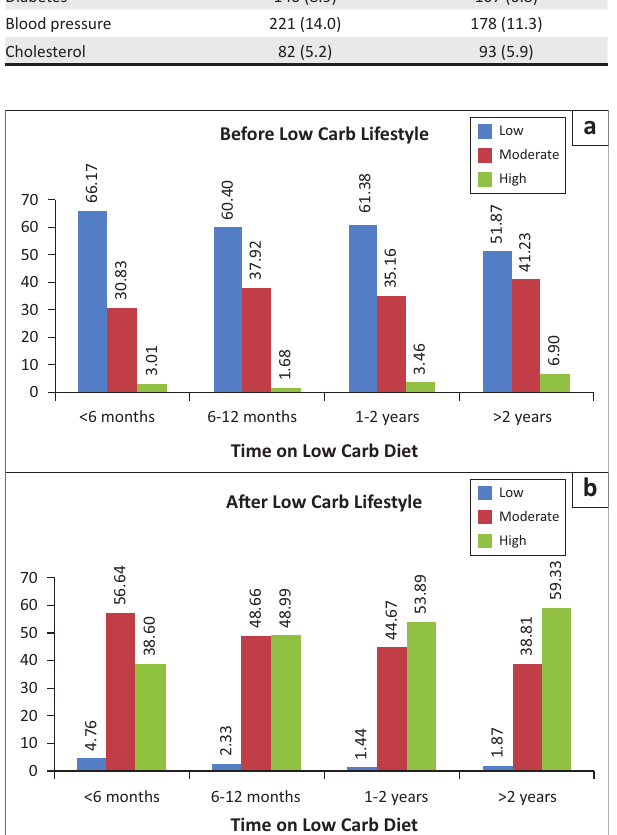
FIGURE 3: Energy level before and after a low-carb diet broken down by amount of time following a low-carb lifestyle.